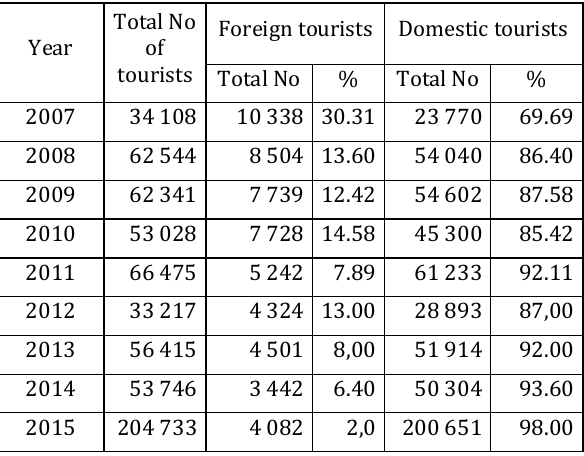
Table 2. Number of foreign and domestic tourists arrivals in Gilgit-Baltistan (2007-2015) (Source: G.B Tourism